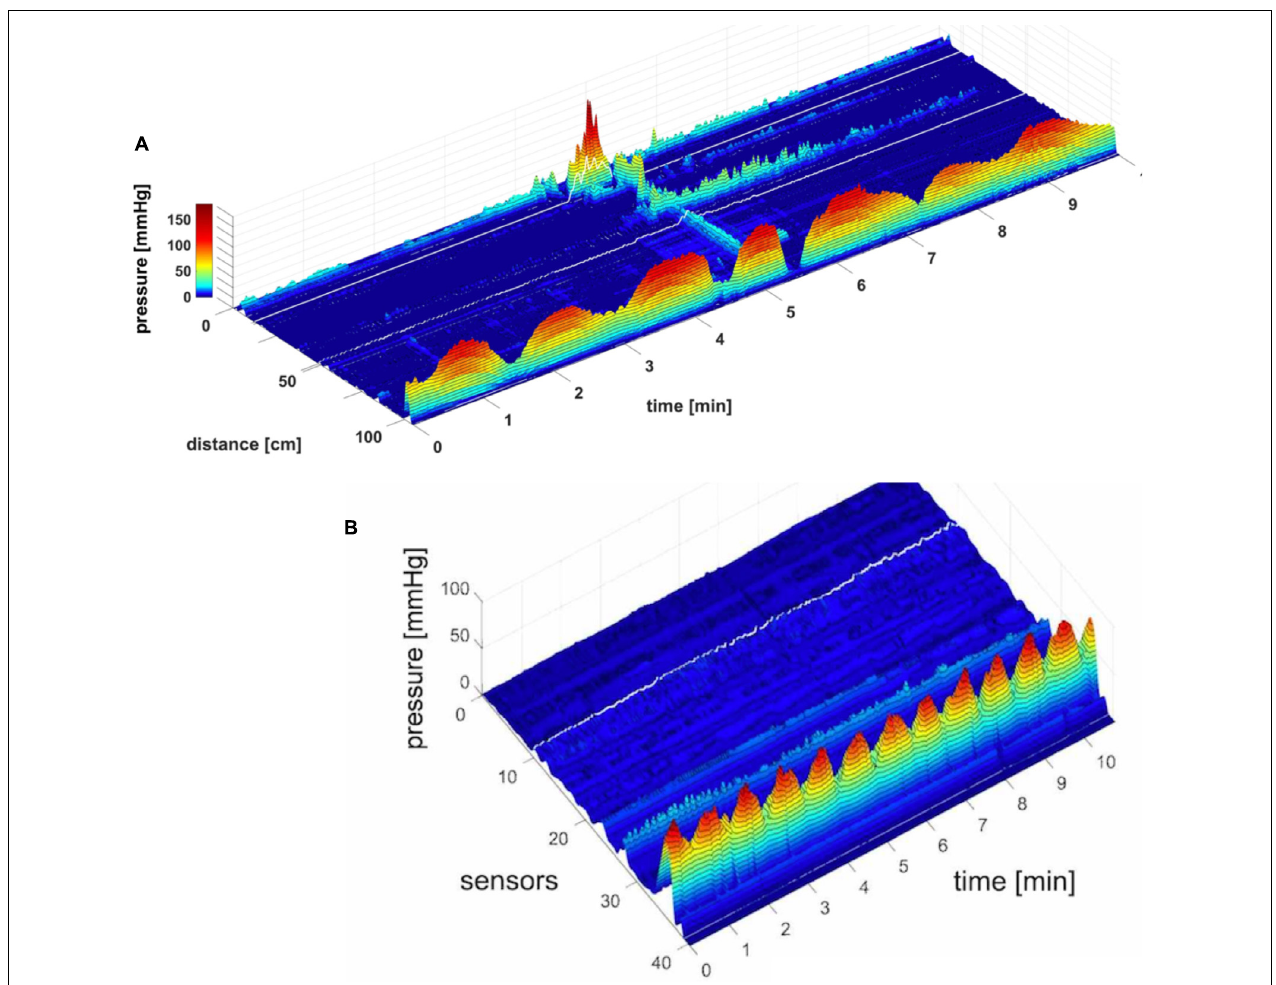
FIGURE 5 | Rhythmic activity of the internal anal sphincter. (A) Rhythmic activity of the internal anal sphincter at 0.7 cpm. In addition, a short proximal HAPW appears followed by an SPW and full anal sphincter relaxation. This activity was recorded 80 min after meal intake. (B) Low amplitude colonic activity during baseline with rhythmic anal sphincter activity at 1.2 cycles per